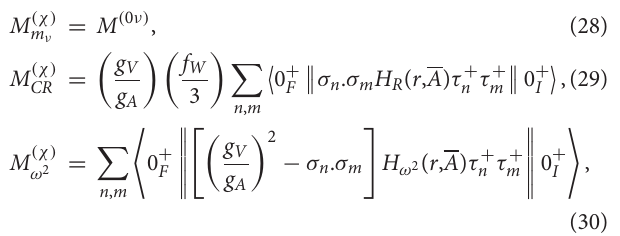
space factors have been calculated to good accuracy by Kotila et al. [128]. In the same Table 3 , NTMEs M ( χ ) α